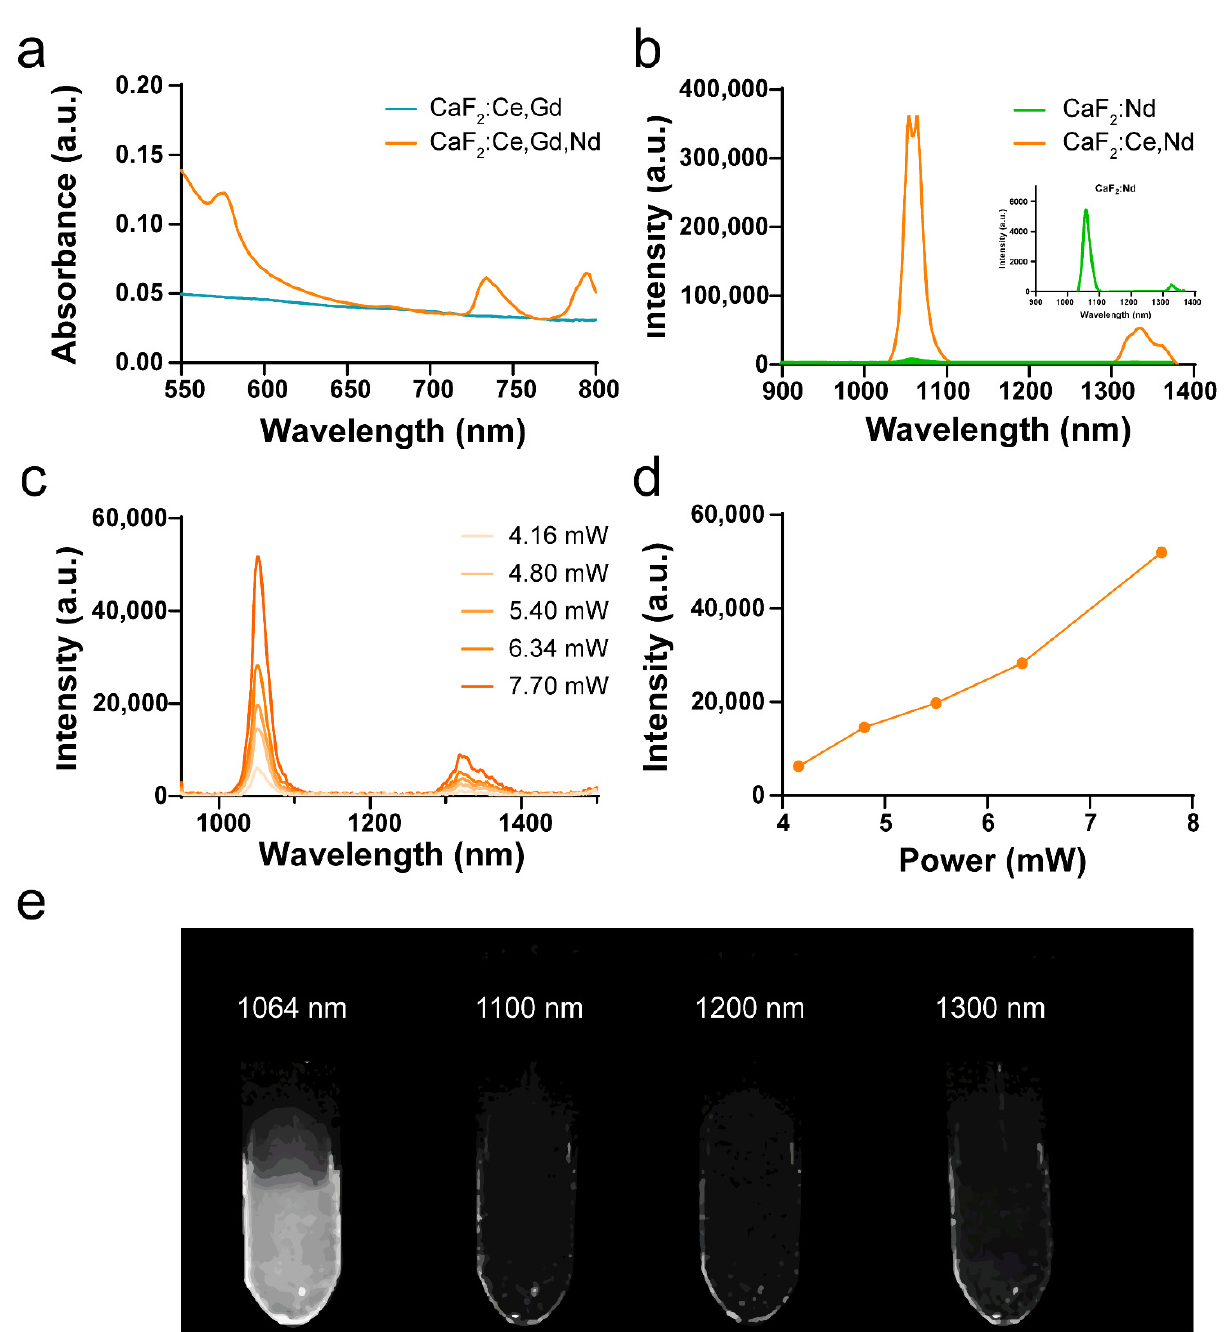
Figure 2. Optical properties of CaF 2 : Ce, Gd, Nd NPs. ( a ) The absorption spectra of CaF 2 : Ce, Gd, Nd NPs solution and CaF 2 : Ce, Gd NPs (10 mg/mL) measured with SpectraMax ® iD3 Multi-Mode Microplate Reader; ( b ) emission spectra of CaF 2 : Nd NPs and CaF 2 : Ce, Nd NPs (powder) measured with Edinburgh FLS920 fluorescence spectrometer with an 808 nm NIR diode laser (300 mW), where the inset shows a zoomed-in spectra of CaF 2 : Nd NPs; ( c ) emission spectra of CaF 2 : Ce, Gd, Nd NPs under 808 nm laser excitation; ( d ) the emission intensities of CaF 2 : Ce, Gd, Nd-NPs at different laser powers (excited by an 808 nm laser); ( e ) NIR-II images of CaF 2 : Ce, Gd, Nd NPs (2 mg/mL) at different wavelengths (excited by an 808 nm laser, 50 mW/cm 2 ).